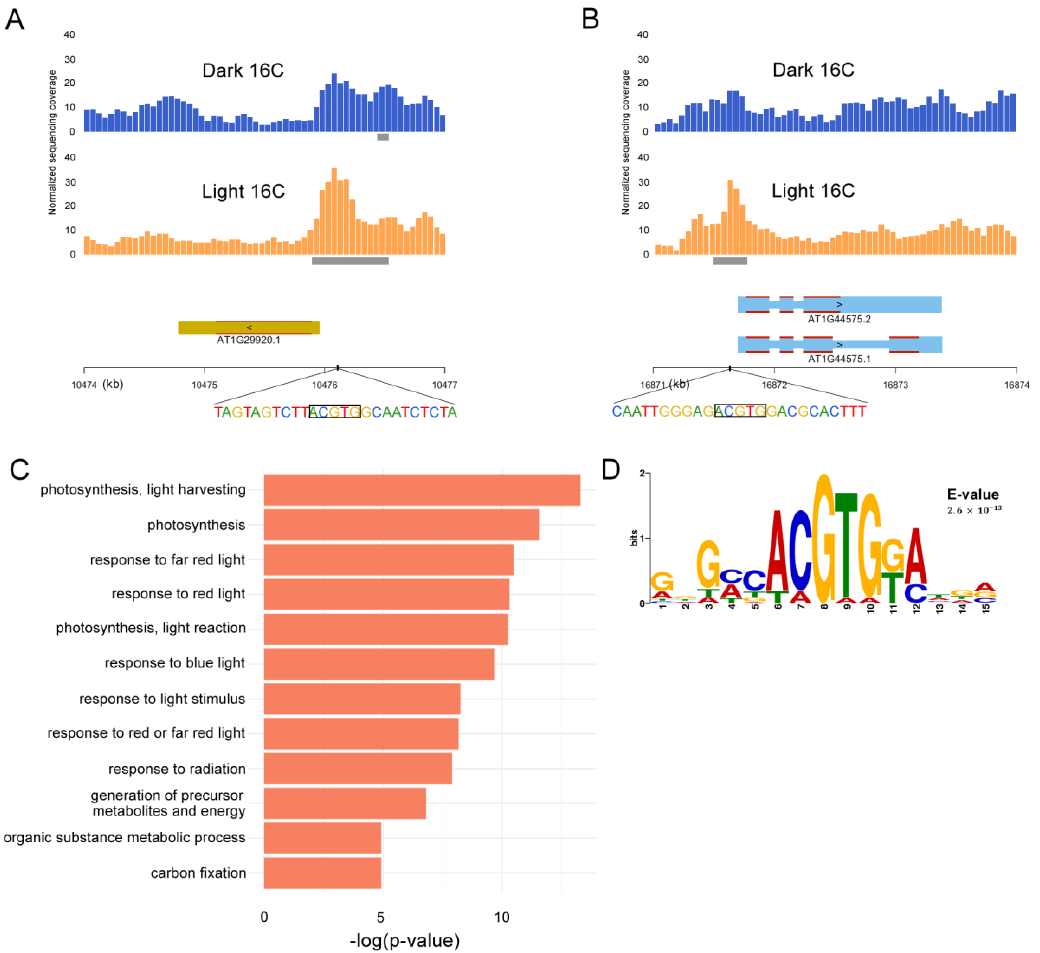
Figure 3. Analysis of differentially accessible genes and regions of dark and light hypocotyls. ( A ) Differential light accessible regions (LAR) ATAC-seq peaks around the promoter of CHLOROPHYLL A/B-BINDING PROTEIN 2 ( CAB2 ) and ( B ) NONPHOTOCHEMICAL QUENCHING 4 ( NPQ4 ). Both genes are on Chr1. Grey bars indicate ATAC-seq peaks annotated by MACS2. ( C ) Gene Ontology (GO) analysis of the 56 genes that are more accessible in light treated hypocotyl in 16C nuclei. ( D ) Sequence Logo of the recovered G-Box motif from the Multiple Em for Motif Elicitation (MEME) motif analysis of all LARs.